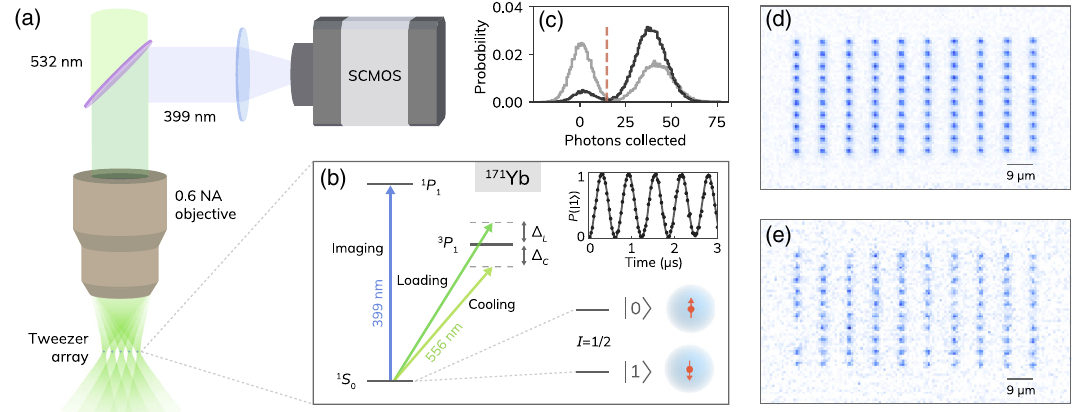
FIG. 1. 171 Yb optical tweezer arrays. (a) 171 Yb atoms are trapped in an array of 100 optical tweezer sites. (b) The nuclear spin I ¼ 1 = 2 is an environmentally well-isolated two-level system. The level diagram shows the imaging, cooling, and enhanced loading transitions. Light scattered from the 399 nm 1 S 0 → 1 P 1 transition is collected with the high-NA objective. While imaging, we apply cooling beams 1 = 2 i transition. The inset shows = ð 2 π Þ ¼ − 2 . 04 ð 5 Þ MHz ( 11 Γ ) from the light-shifted 1 S 0 → 3 P 1 j F 0 ¼ 3 = 2 ; m red detuned by Δ C g F 0 ¼ (cid:3) driven Rabi oscillations of the nuclear spin with submicrosecond π times. (c) Histograms of collected photons over all tweezer sites for 120 ms exposures under two different loading schemes — enhanced loading (black line) and standard (zero-field, red-detuned light) loading (gray line). The dashed red line is the threshold that we use to define detection of an atom in the enhanced loading case. (d) Average of 500 images of the tweezer array. (e) Single-shot image with near-deterministic tweezer array